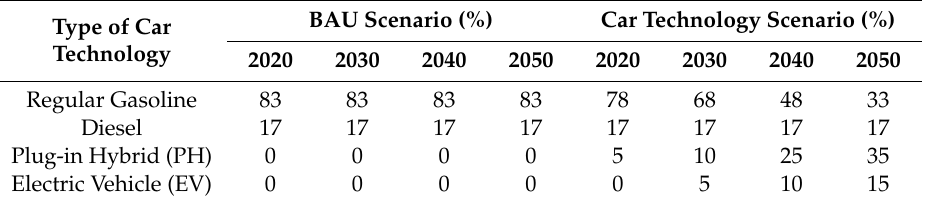
Table 2. Comparison of percentages of new car sales by car technology and